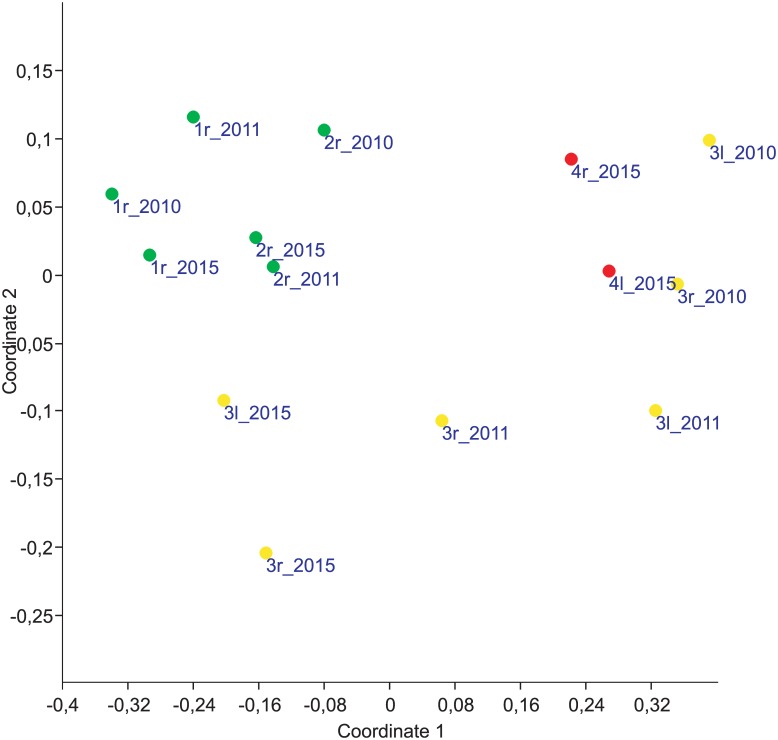
Nonmetric multidimensional scaling of N. melanostomus performance metrics.Nonmetric multidimensional scaling (NMDS) of N. melanostomus population-specific performance metrics calculated from point-abundance sampling data (autumn 2010, 2011 and 2015) in the upper Danube River, Bavaria, southern Germany. Dissimilarity-distances between 14 samples from four river stretches were calculated using the squared euclidian distance and displayed in green (“established area” with stretches #1 and #2), yellow (“invasion front 2010”, stretch #3) and red spots (“invasion front 2014”, stretch #4). The spot labels are encoded with sampling stretch number, river side (r = right, l = left) and year of sampling. LT(f), LT (m), LT(j), MT(f), MT(m), MT(j), K(f), K(m), K(j), proportion of females and catch data (mean CPUE and frequency of occurrence of (i) N. melanostomus, (ii) Barbus barbus and Squalius cephalus (combined) and (iii) other fish species) from the corresponding sampling sites were used as variables (stress = 0.05).